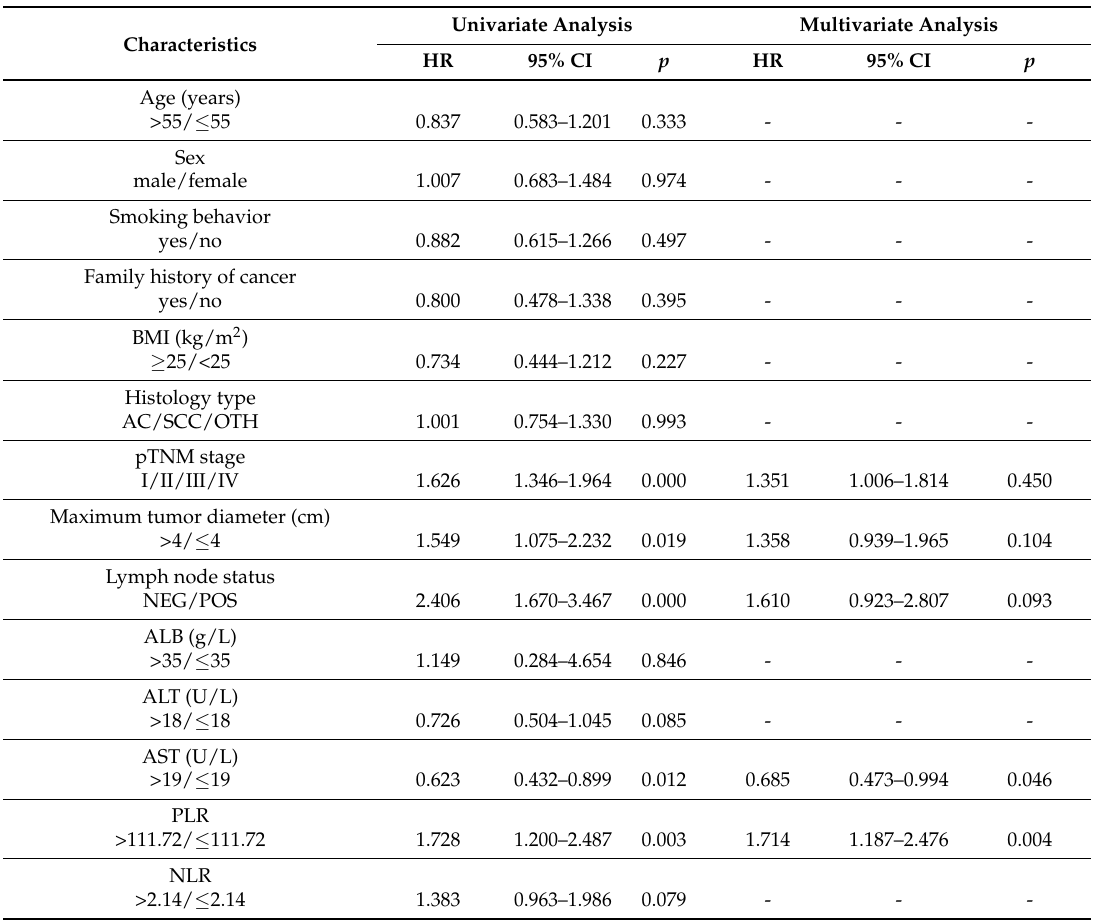
Table 3. Univariate and multivariate analyses of RFS.